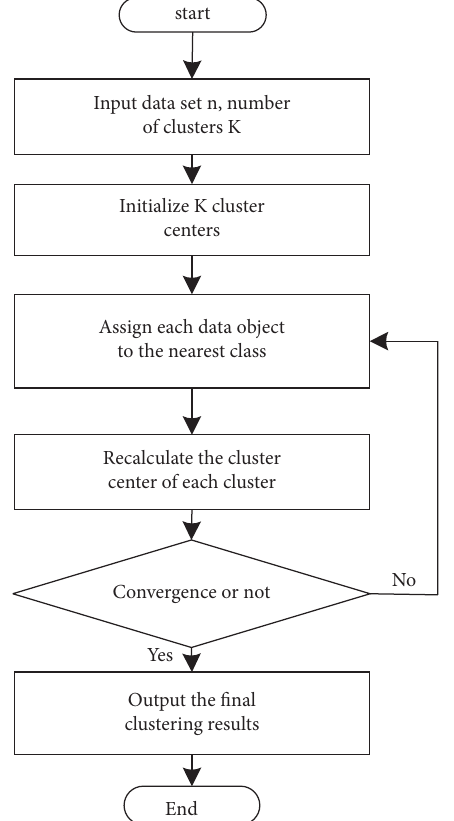
Figure 4: Workflow of K-means clustering